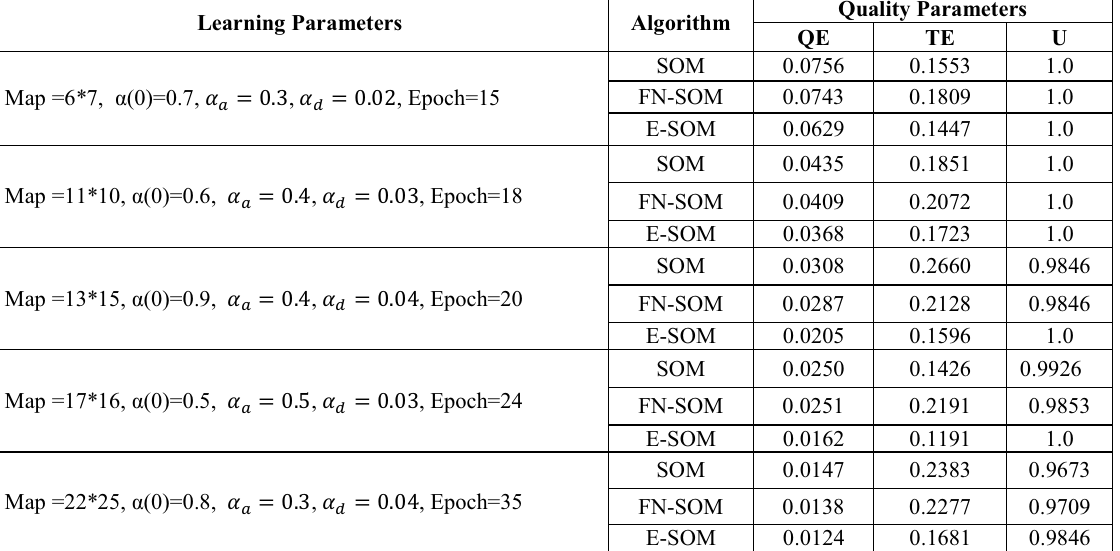
Table 3. Quantization error Qe, Topographic error Te and Neuron Utilization U for the Gaussian Mixture dataset (Experiment